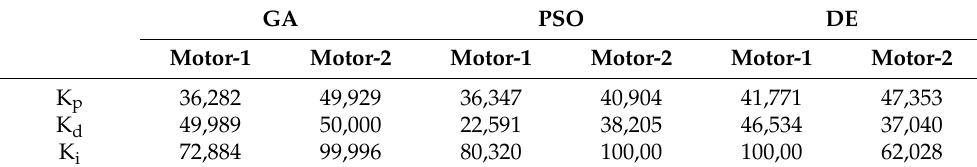
Table 5. PID gains.